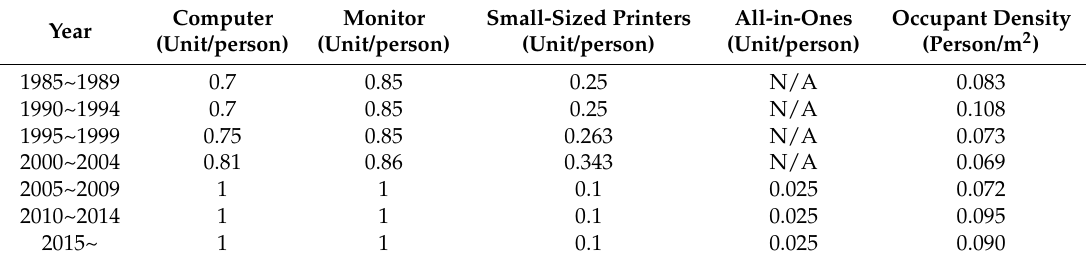
Table 7. The number of OA appliances used per person and the density of occupants.